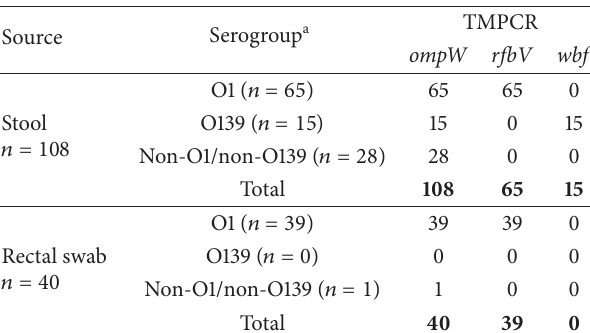
Table 5: Agreement of O serogroup-specific TMPCR for detecting and differentiating gDNAs of the O1, O139, and non-O1/non- O139 serogroups archived from clinical samples ( 𝑛 = 148), using serotyping method as